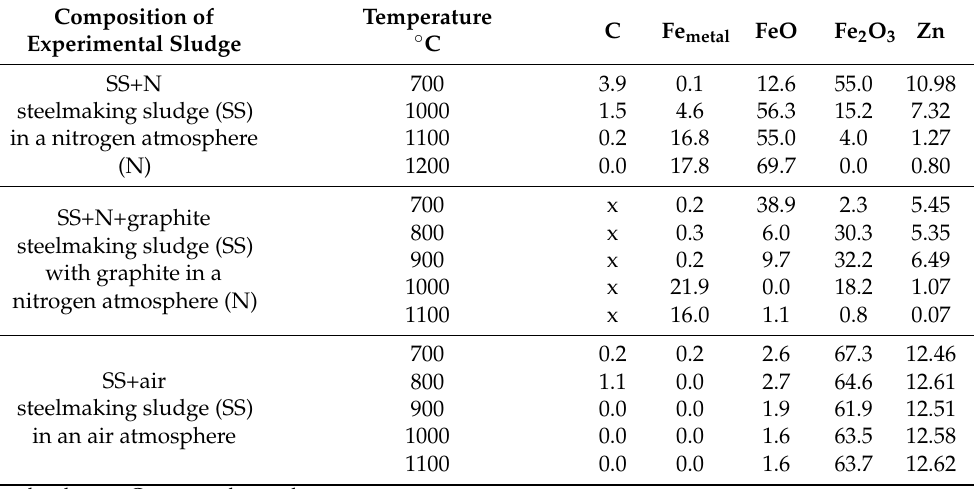
Table 4. The chemical composition of the experiments carried out for steelmaking sludge [wt.%] XRFS analysis.